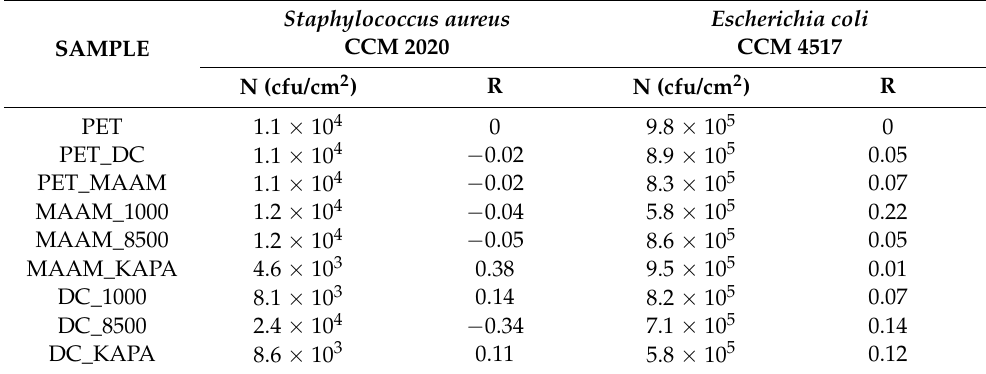
Table 3. Viable bacteria numbers on PET surfaces; antibacterial effect (R) values are expressed in CFU.